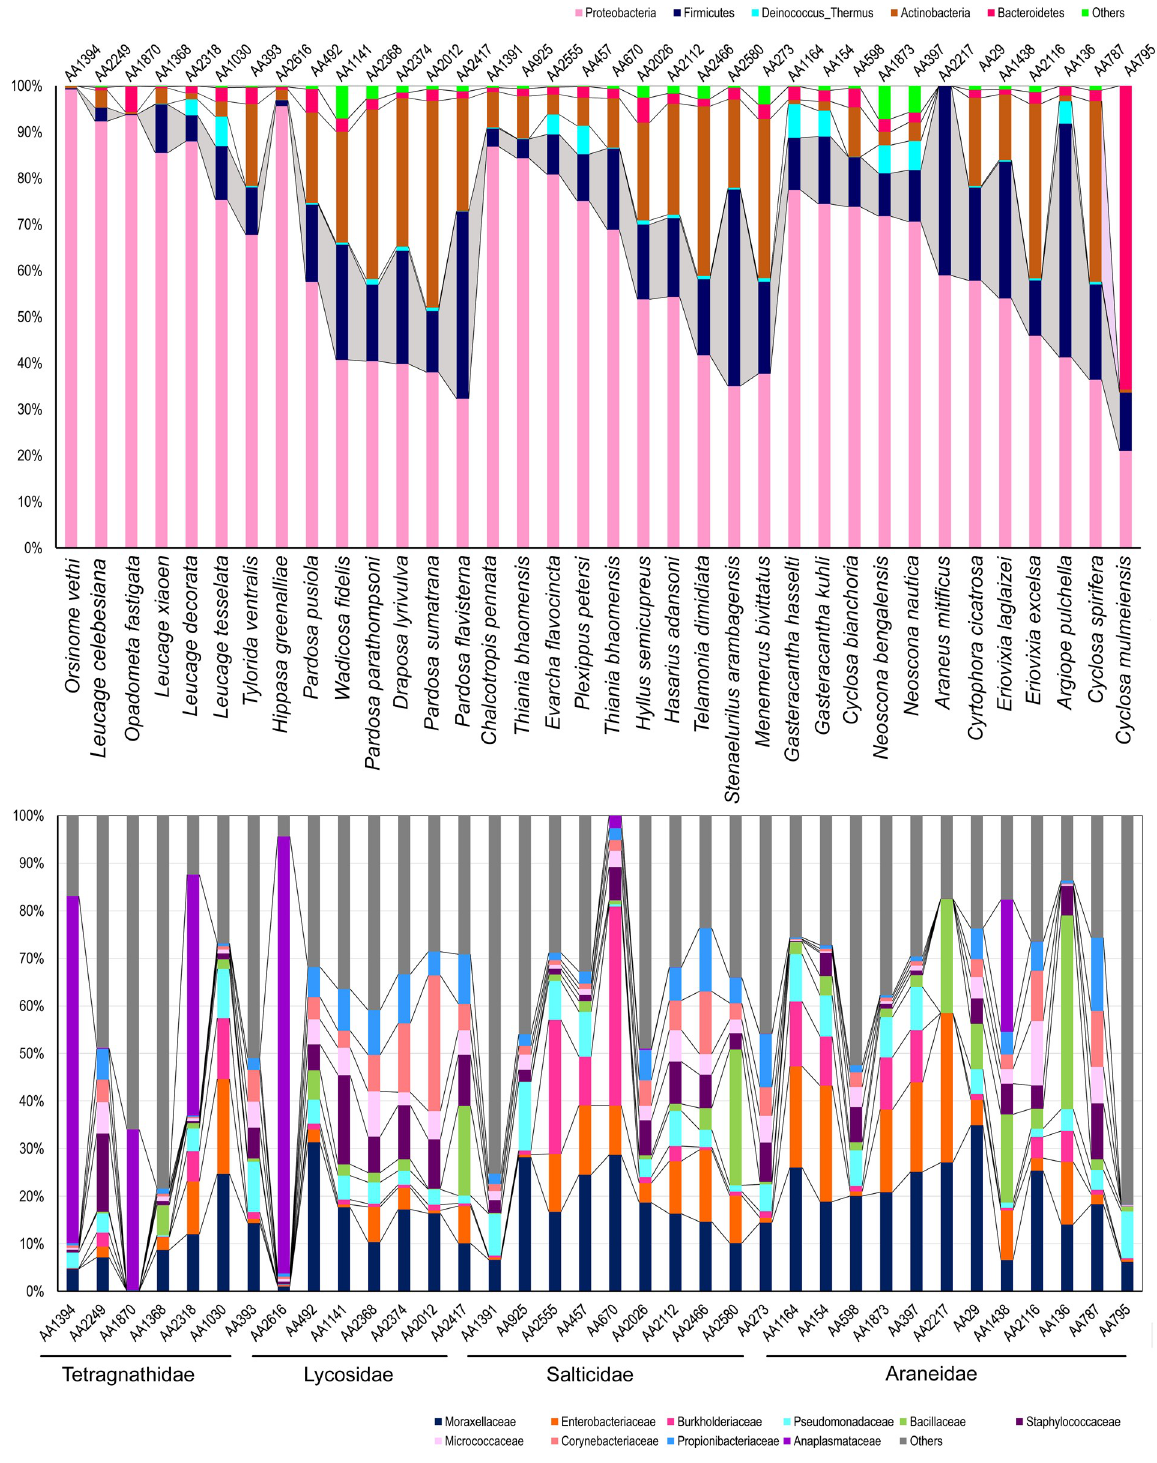
Fig 2. The gut bacterial diversity of spider species based on dominant phyla and families.